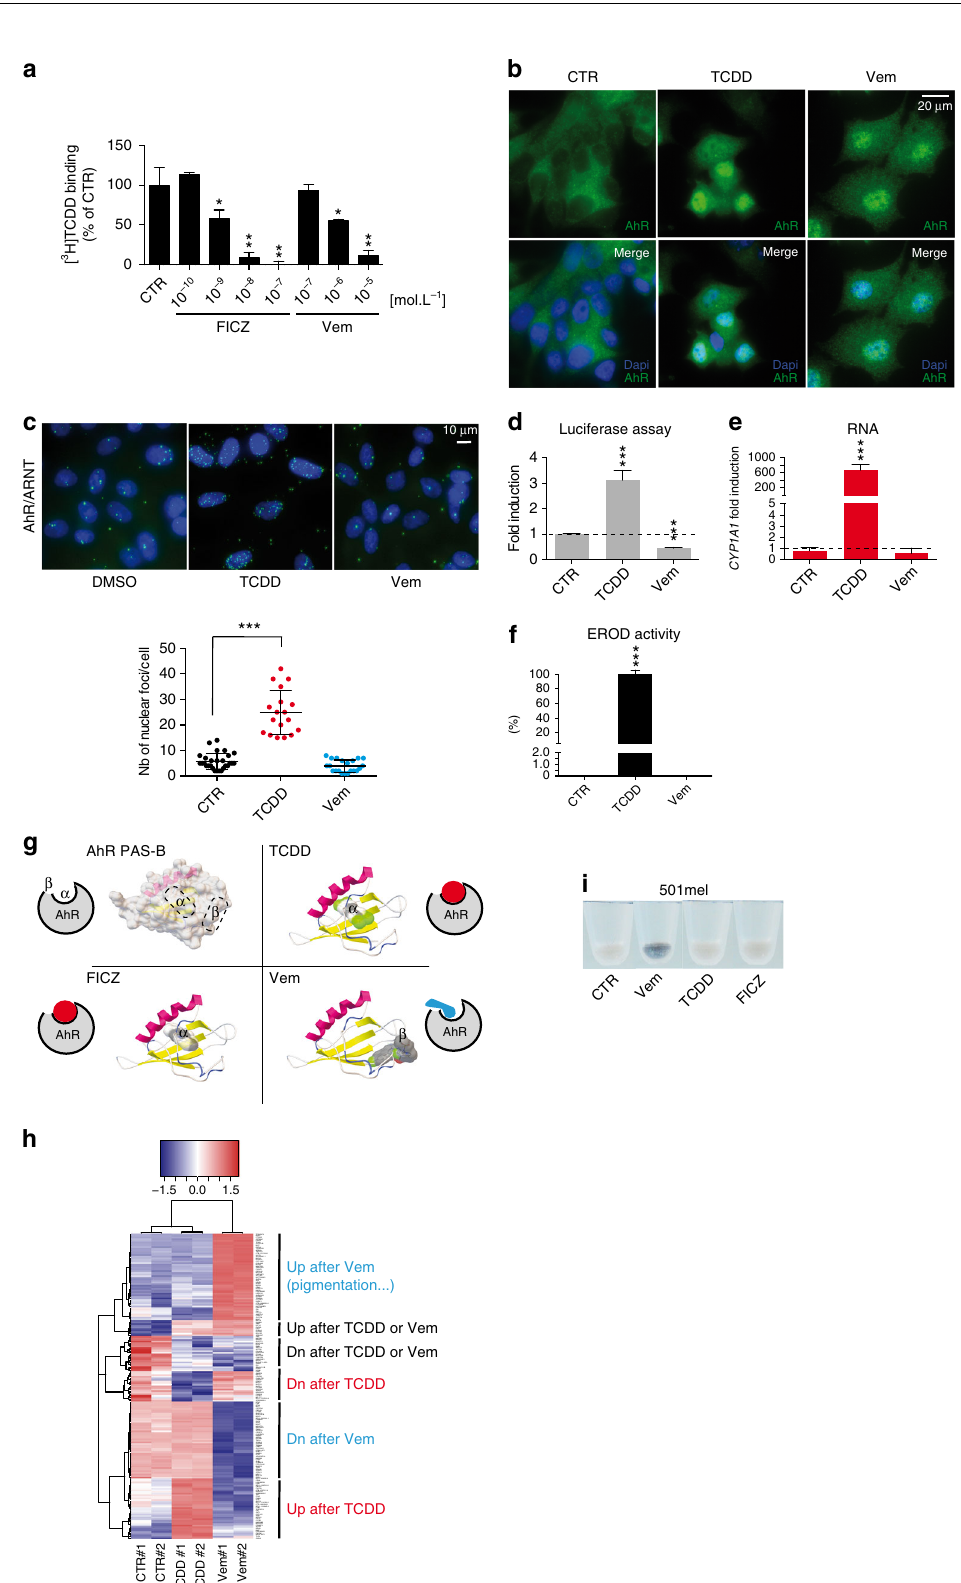
overlapped with the invasive gene expression signature 15 and dedifferentiated cell state (Fig. 2c) 10,15,16,30,31 . To challenge these observations, we fi rst re-analyzed the recently published Graeber ’ s melanoma data sets 10 using their online webtool characterizing melanoma subtypes (M, T, N, or